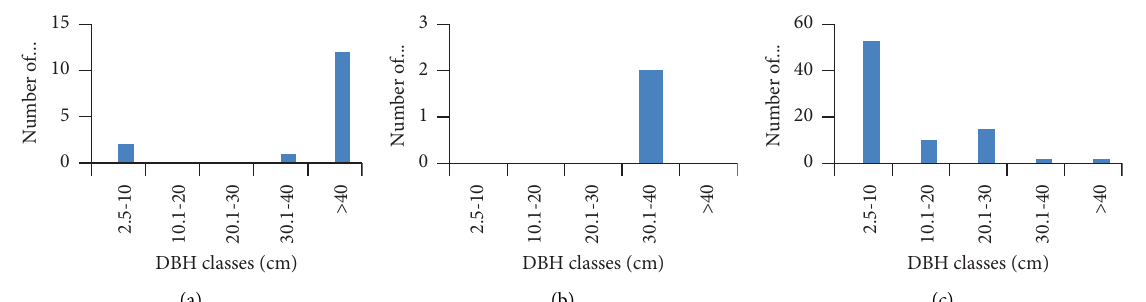
Figure 10: Tree representative patterns of population structure in Jib Godo Natural Forest. (a) Interrupted shape, (b) I shape, and (c) inverted J